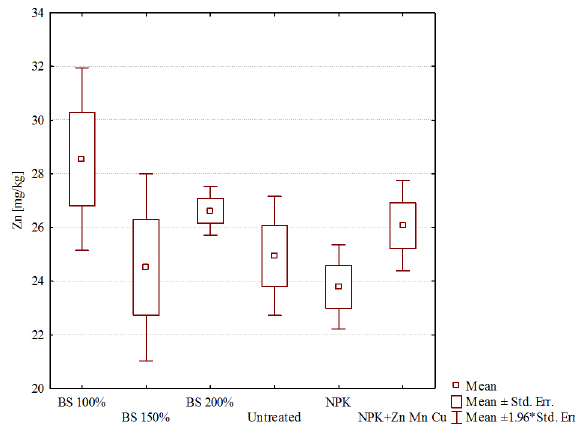
Figure 6: Zinc content [mg kg -1 ] in grain vs.